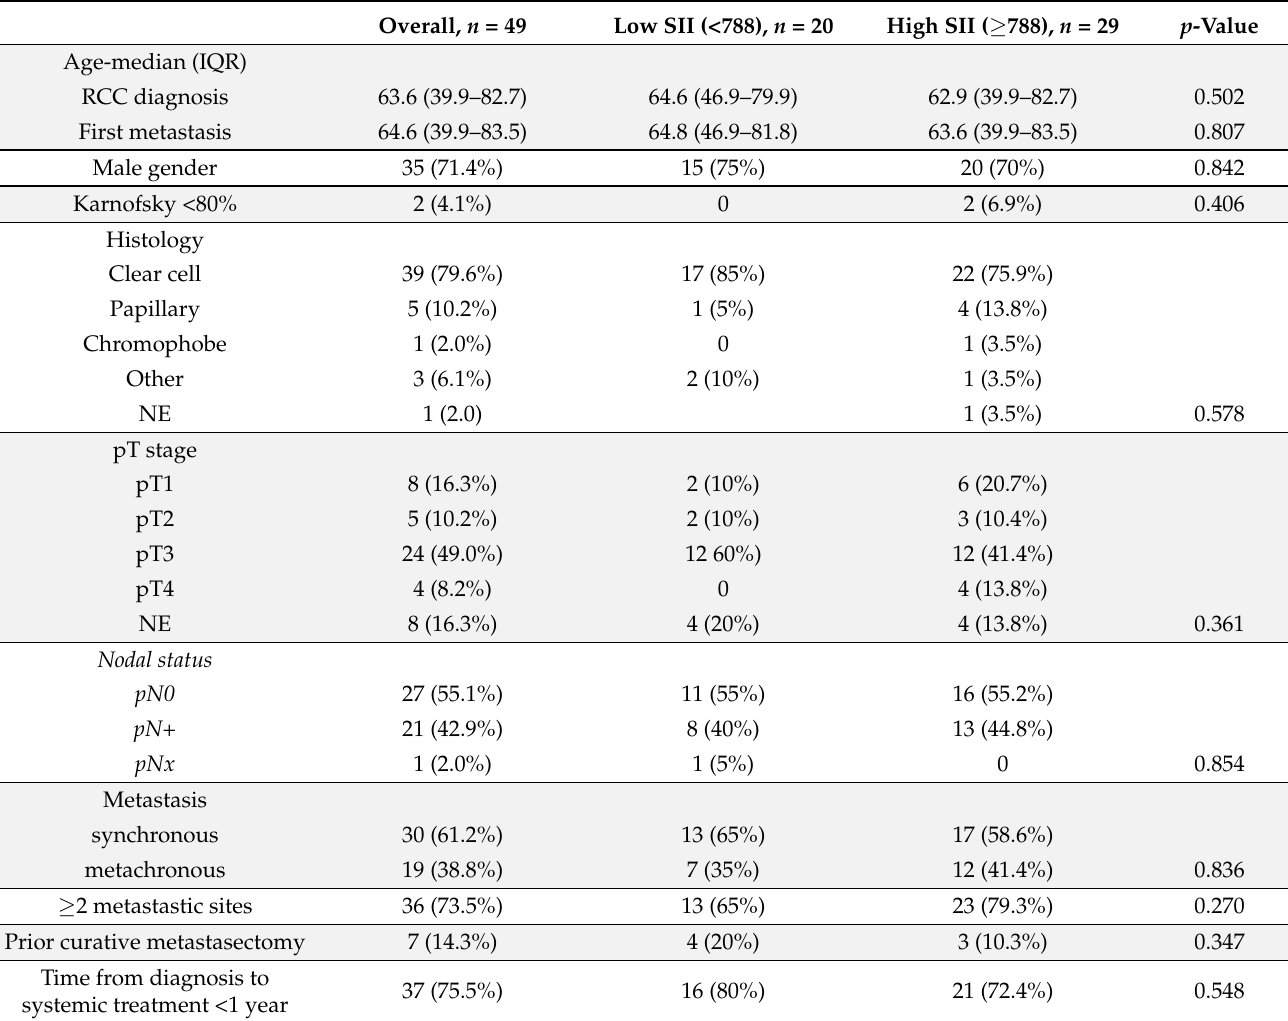
Table 1. Patients’ characteristics according to the peripheral blood SII level low (<788) vs. high ( ≥ 788) in patients with mRCC treated with first-line ipilimumab plus nivolumab. Overall, n = 49 Low SII (<788), n = 20 High SII ( ≥ 788), n = 29 p